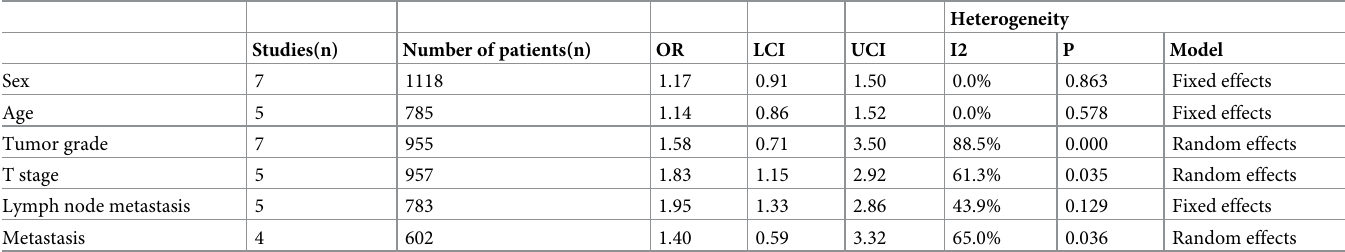
Table 3. Meta-analysis of the relationship between overexpressed GPRC5A and clinicopathological parameters.